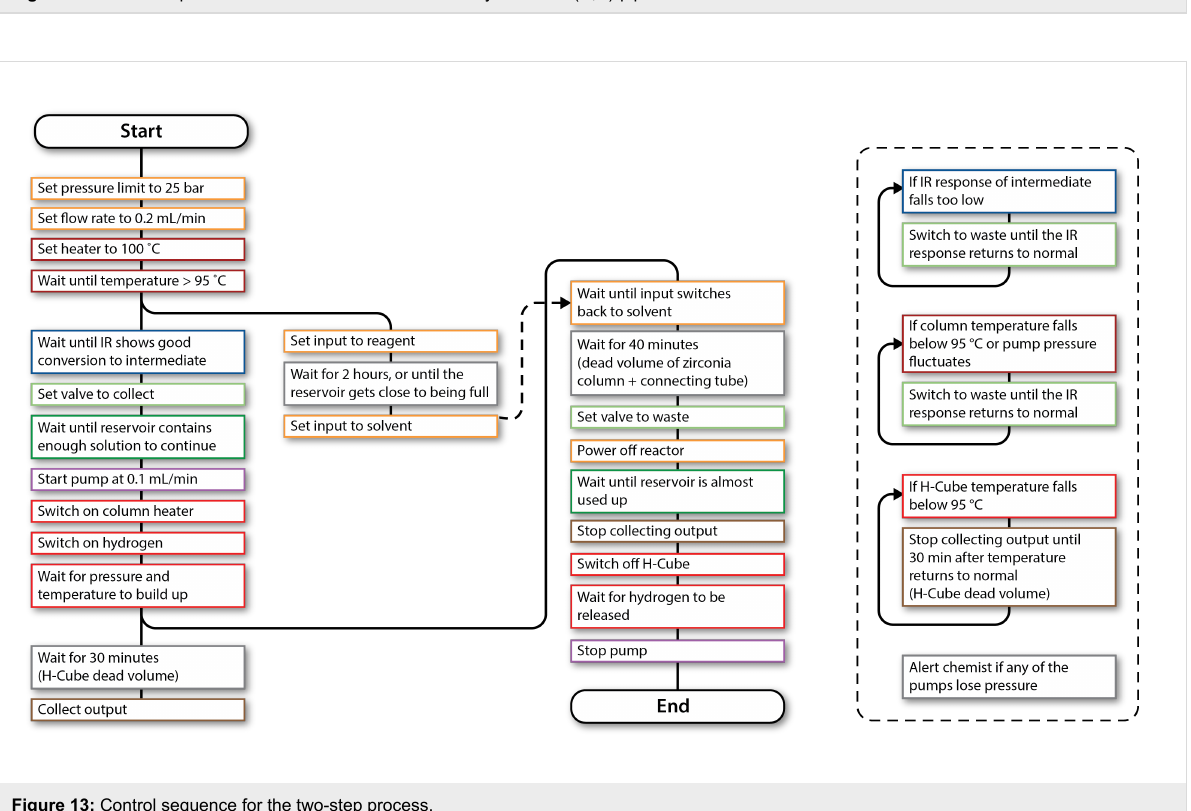
conversion in the H-Cube ® was relatively low, which limited the throughput of the material in the reduction step. This could be mitigated if larger-scale hydrogenation apparatuses were